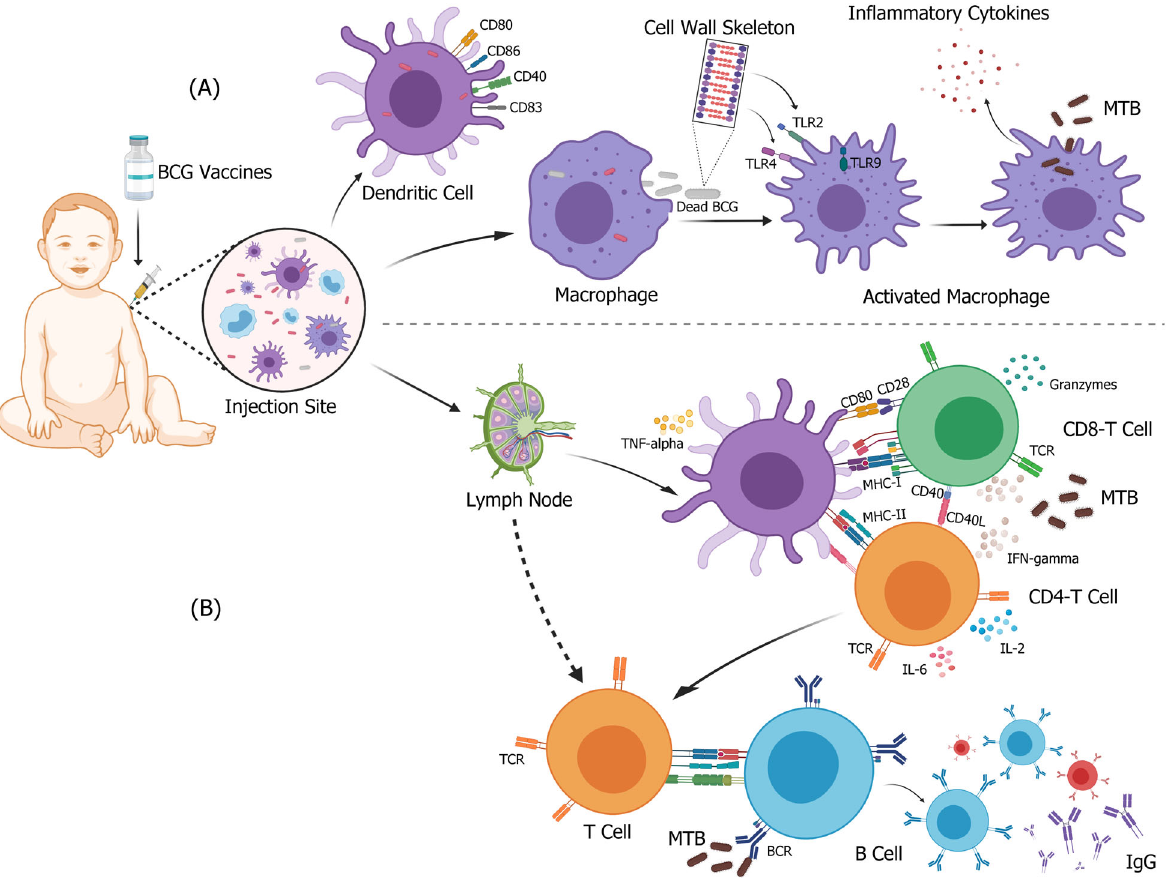
Fig. 1 Immune response elicited after BCG vaccination-speci fi c effects for MTB. After BCG vaccine is injected intracutaneously, monocytes, macrophages, and DCs recognize the BCG at the vaccination site and form a strong immune response. A BCG is recognized and internalized by DCs or macrophages. The cell wall or other components of BCG act as PRRs that bind to different ligands, upregulate costimulatory molecules of stimulated cells, and activate anti-TB innate immune response. B Activated DC cells migrate to lymph nodes to activate mycobacterial speci fi c CD4 + and CD8 + T cells with a Th1 pro fi le, and subsequently induce the secretion of high levels of cytokines, such as IFN-gamma and granzyme. At the same time, B cells that respond to BCG antigens lead to the production of memory cells, plasma cells, and antigen-speci fi c antibodies. Figure was created using